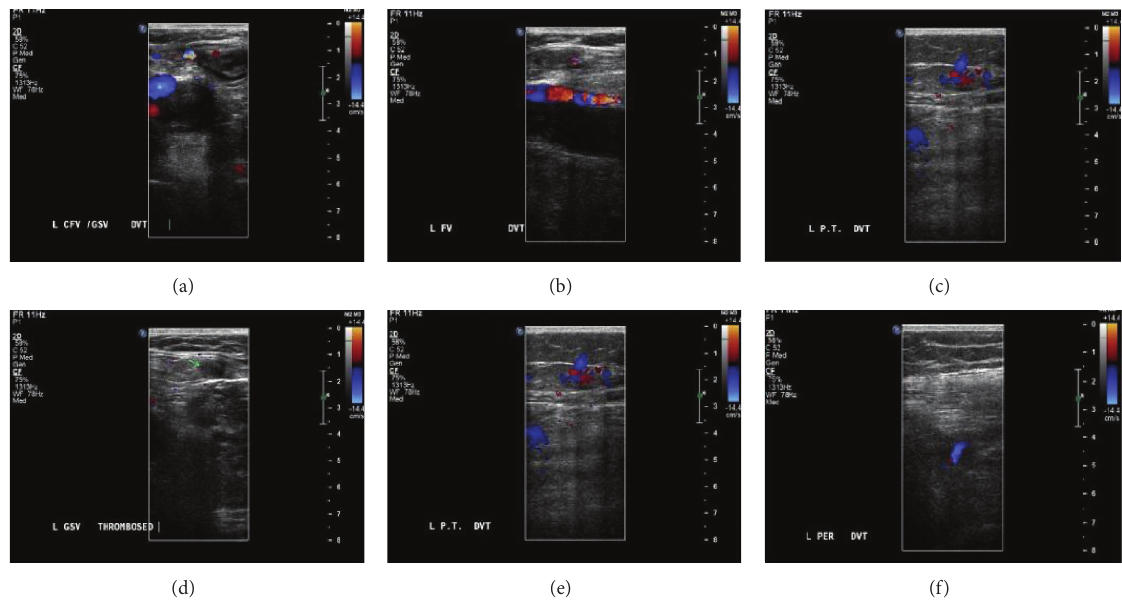
Figure 1: The left common femoral (a); left femoral (b); left popliteal (c); left great saphenous (d); left posterior tibial (e); left peroneal veins (f) demonstrate extensive thrombosis, loss of flow on Doppler. Veins also demonstrate an increase in the size and noncompressibility with ultrasound probe which are consistent with